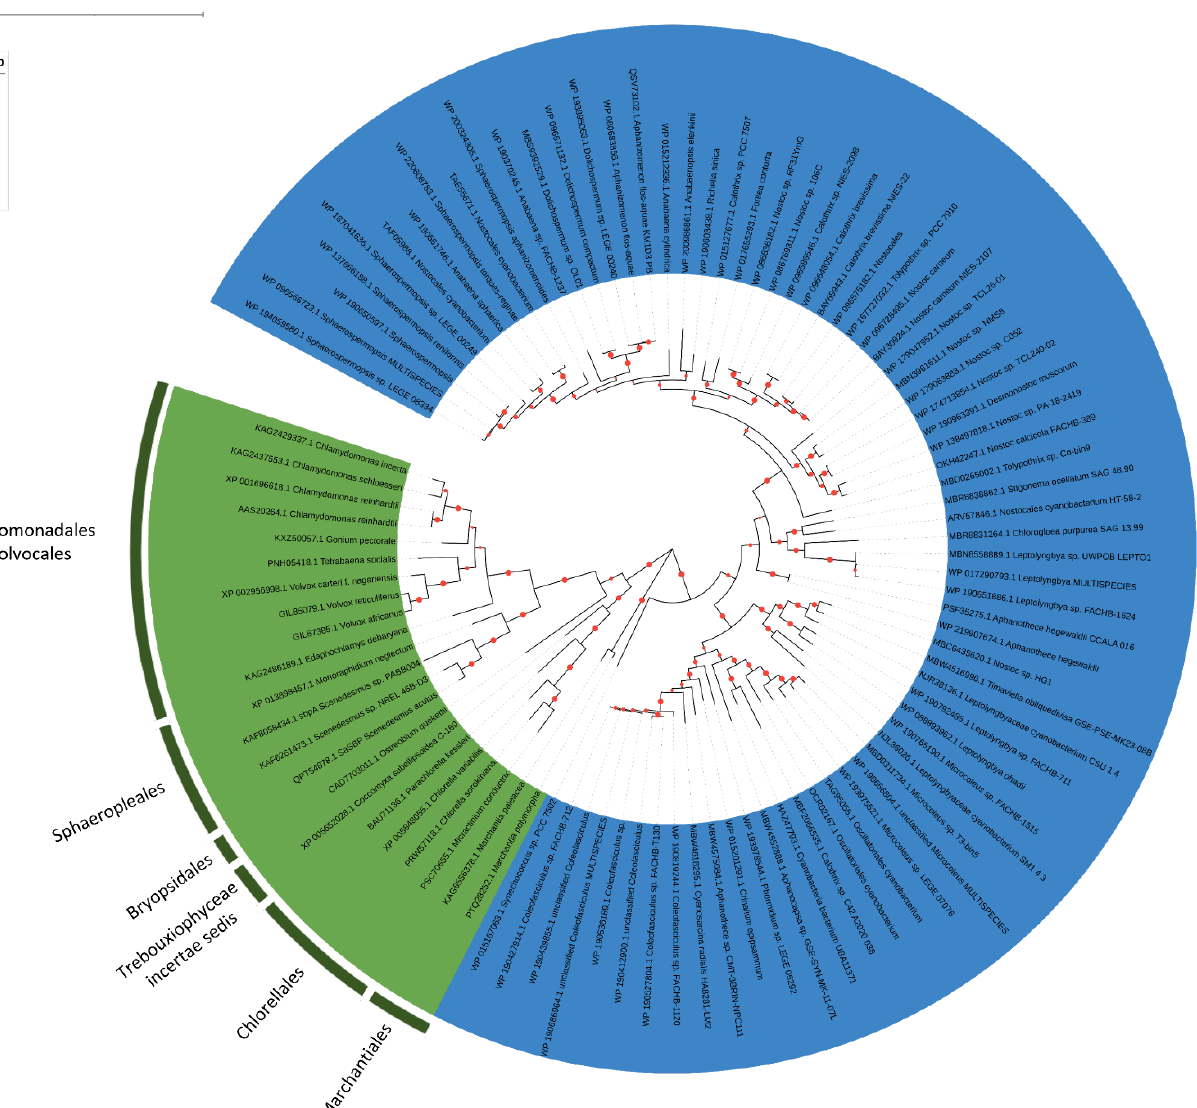
Figure 9. The evolutionary history of SBP. The tree with the highest log likelihood ( − 30,114.72) is shown. The percentage of trees in which the associated taxa clustered together is shown below the branches. The tree is drawn to scale, with branch lengths measured in the number of substitutions per site. This analysis involved 95 amino acid sequences (Table S1) for a total of 2323 positions in the final dataset.